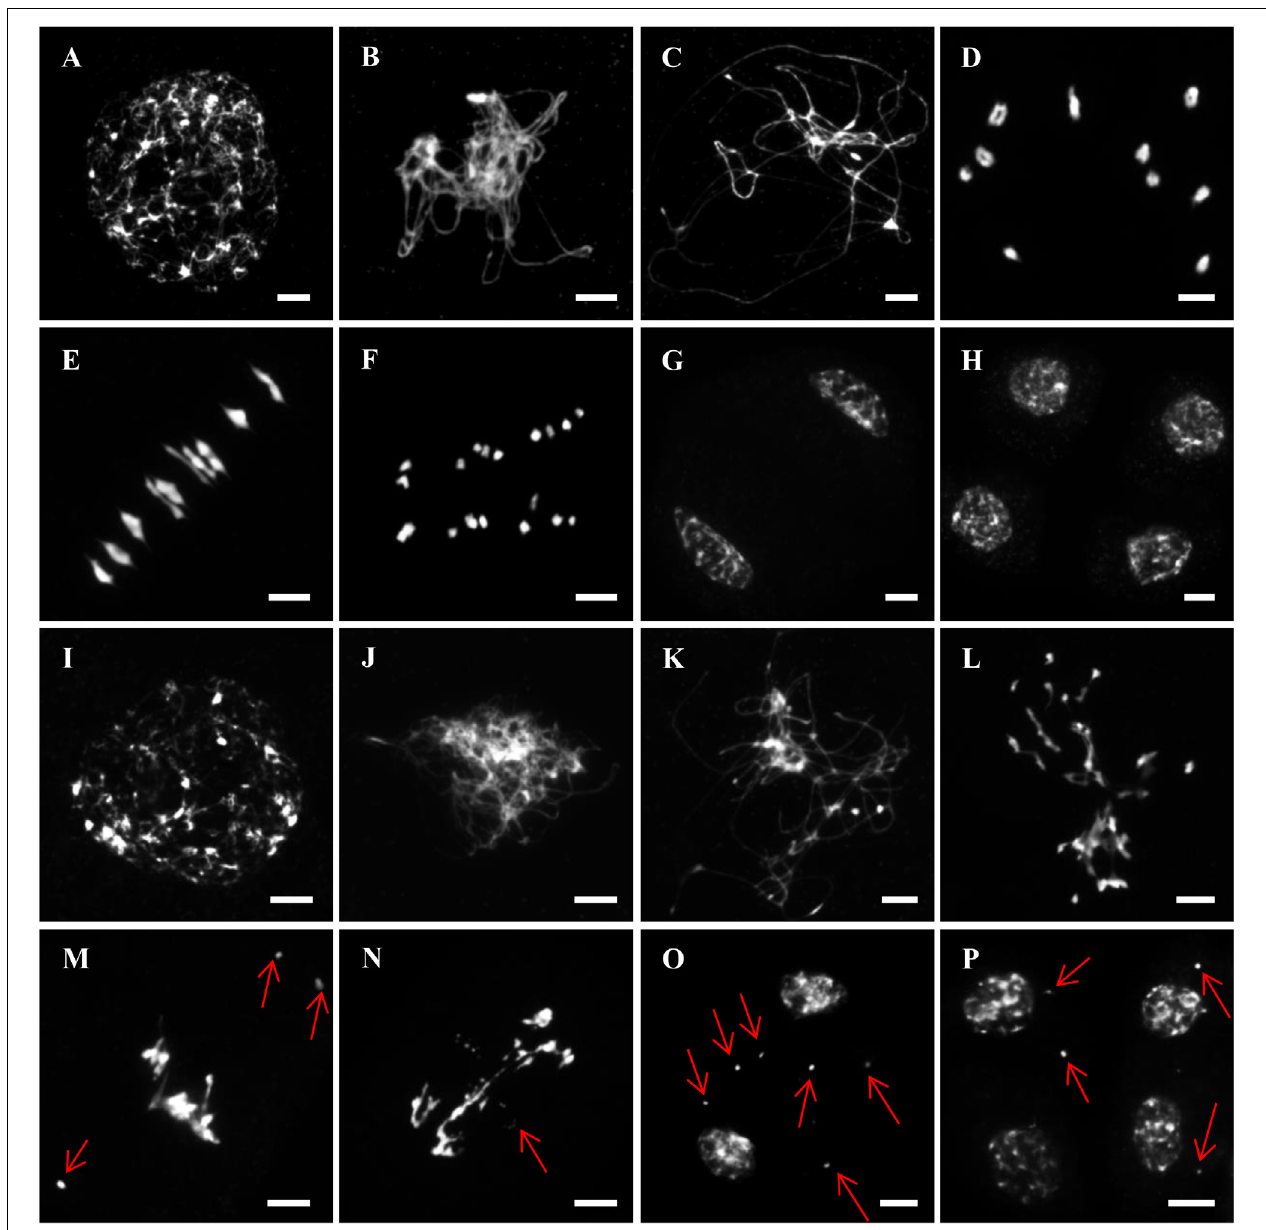
FIGURE 3 | Male meiosis in wild type and Zmcom1-1 . (A–H) Meiosis in wild type. (A) Leptotene; (B) Zygotene; (C) Pachytene; (D) Diakinesis; (E) Metaphase I; (F) Anaphase I; (G) Dyad; (H) Tetrads. Scale bars = 10 µ m. (I–P) Meiosis in Zmcom1-1 . (I) Leptotene; (J) Zygotene; (K) Pachytene; (L) Diakinesis; (M) Metaphase I; (N) Anaphase I; (O) Dyad; (P) Tetrads. The red arrows pointed out the chromosomal fragments and abnormal bridges. Scale bars = 10 µ